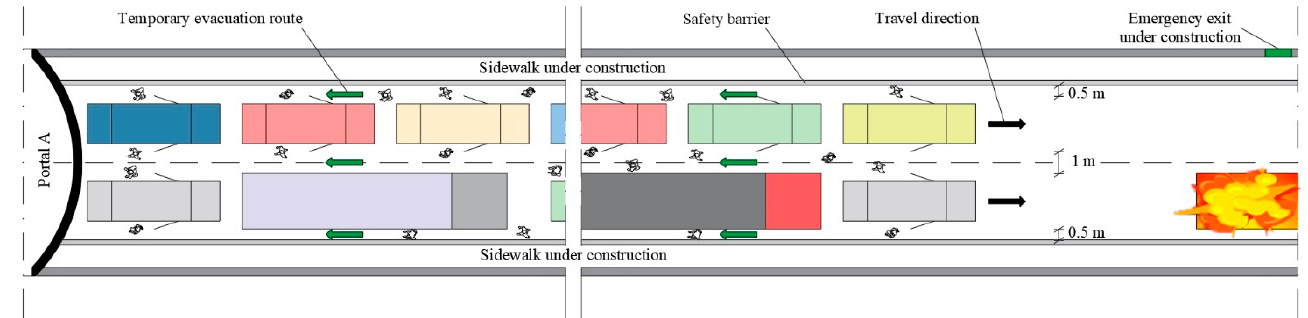
Figure 5. Layout of vehicles in the queue upstream of the fire source for the investigated tunnel.